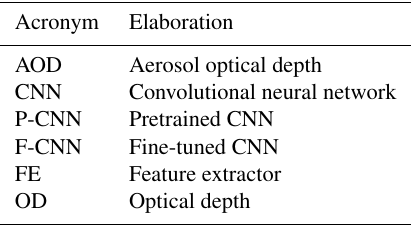
Table 1. Commonly used acronyms that are used throughout this